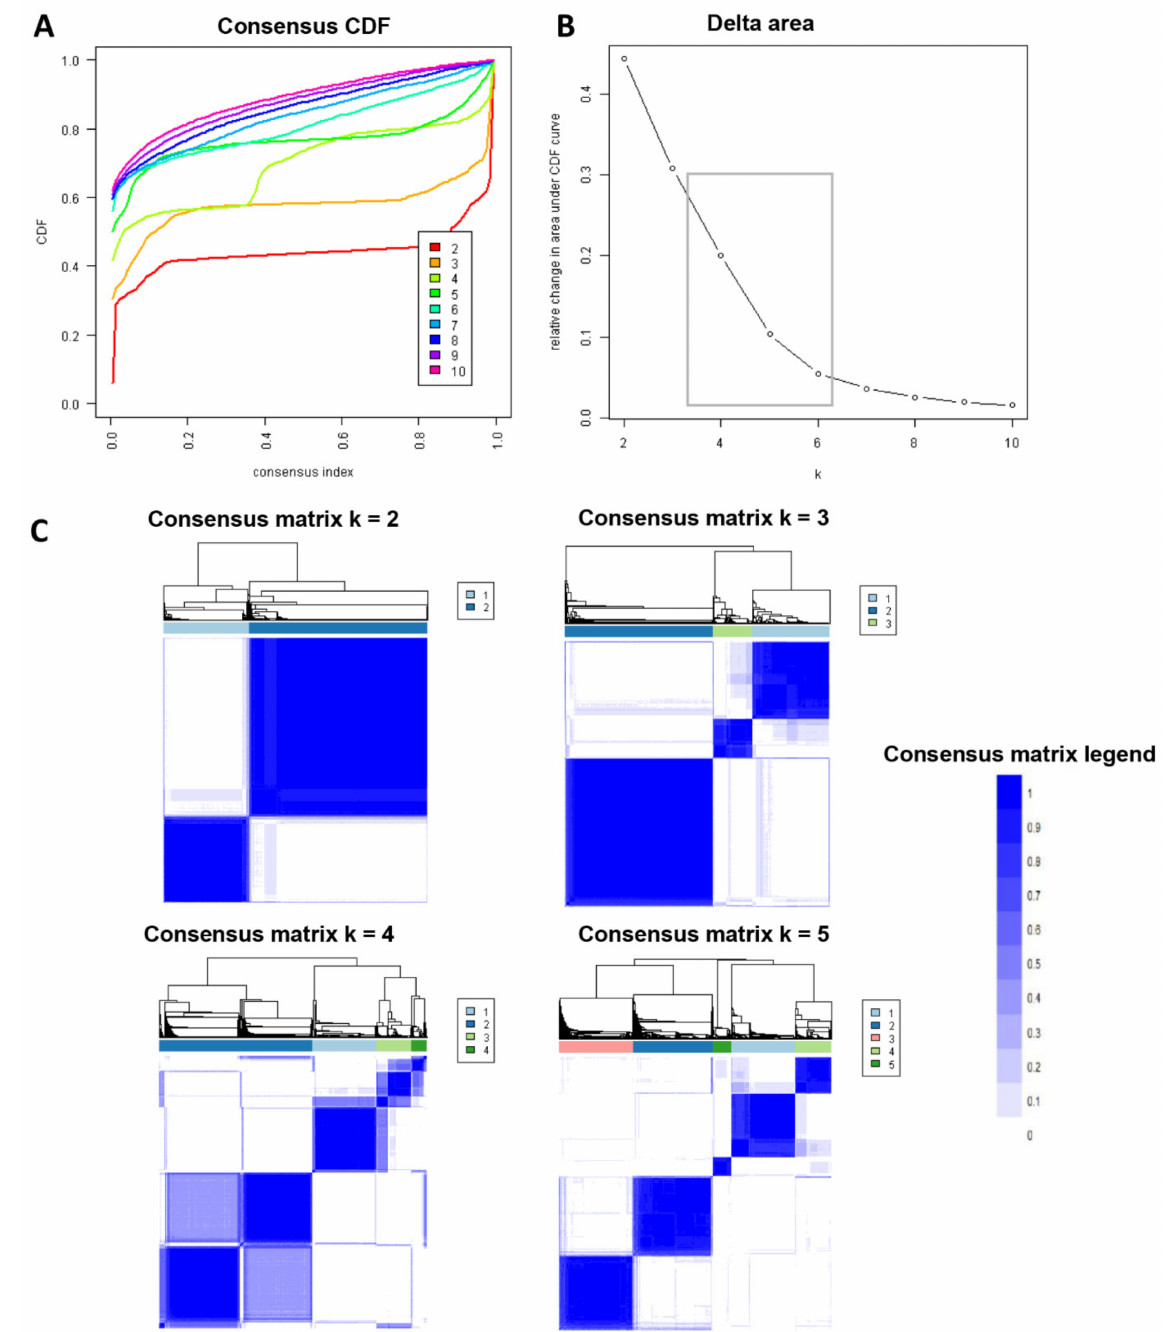
Figure 1. ( A ) CDF plot displaying consensus distributions for each k. ( B ) Delta area plot reflecting the relative changes in the area under the CDF curve. ( C ) Consensus matrix heat map depicting consensus values on a white to blue color scale of each